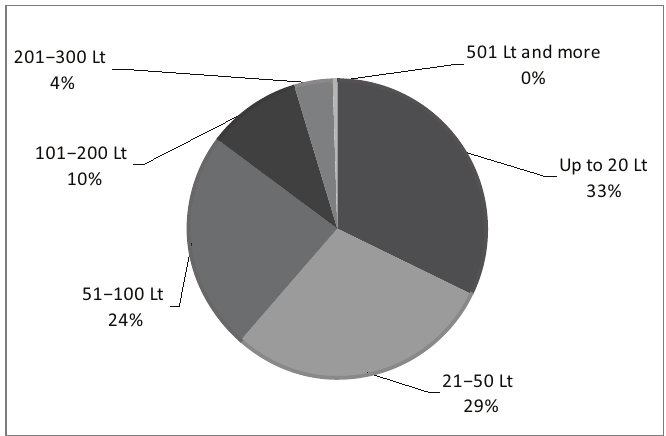
Fig. 19. Expenses during the festival period (including entrance ticket, overnight if needed, etc.)